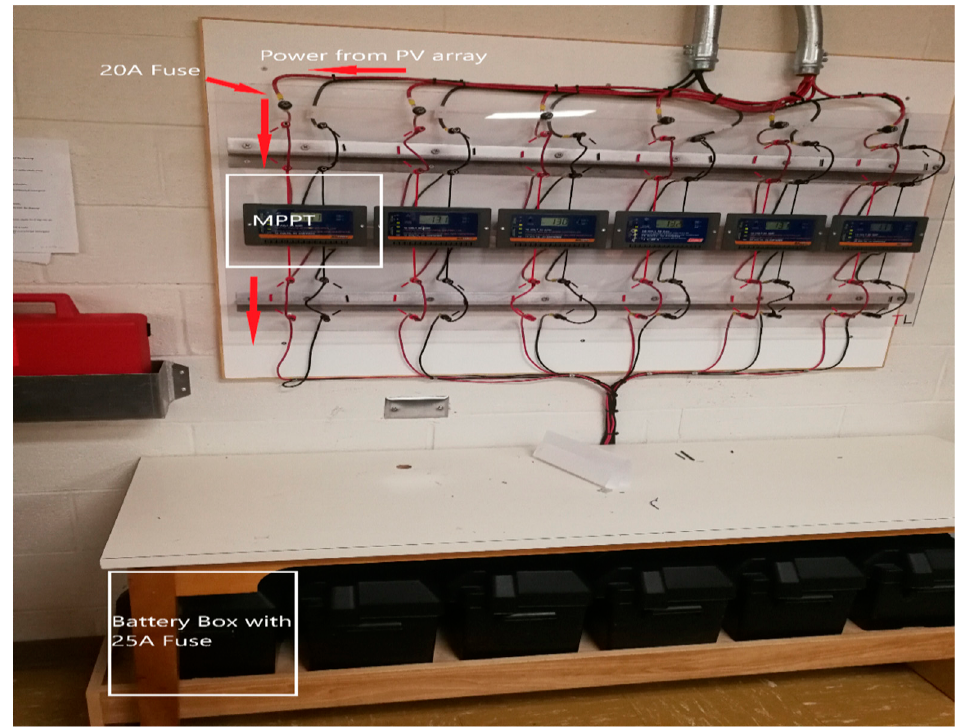
Figure 6. PV system in lab (without PV array).